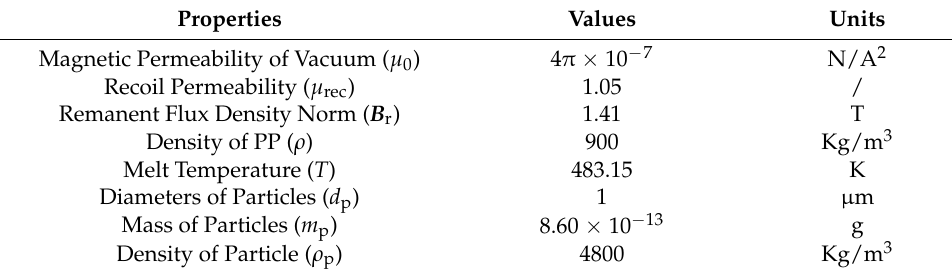
Table 2. Parameters used in the multiphysics model.